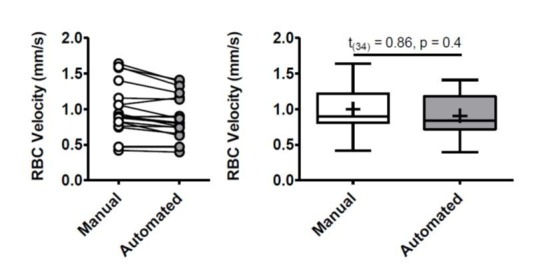
IFT80 Western blots.Western blots performed on lysates of parental and Ift80null mIMCD-3 cells expressing human truncation mutants using various conditions and antibody concentrations could not detect mouse or human IFT80. Two representative Western blots are shown using anti-IFT80 antibodies #25230-1-AP from ProteinTech (A) or #PAB15842 from Abnova (B). The expected molecular weight of endogenous human IFT80, which should be expressed in the parental cell line (left lane) is indicated by a red arrowhead.